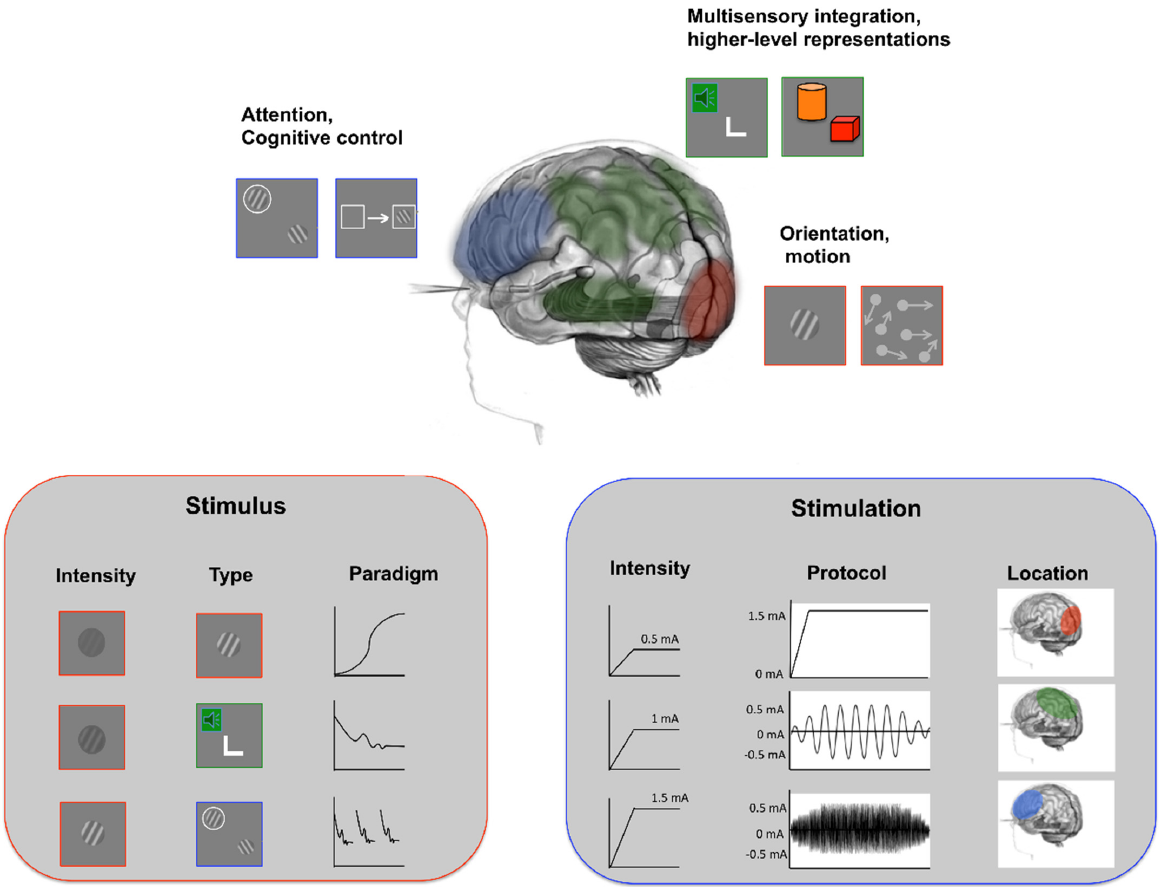
Figure 1. Stimulation and training features contributing to learning outcomes. Our current under- standing of both VPL and tES indicates that several elements concur in generating the behavioral improvements reported in both literature studies, and optimizing these aspects can help boost learn- ing outcomes. Characteristics of the visual stimulus can engage different sensory, attentional and cognitive areas, while characteristics of the stimulation can boost or inhibit perceptual and learning